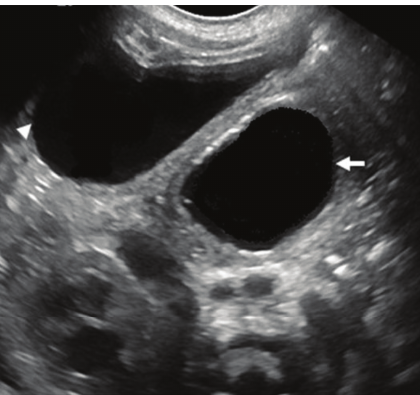
Figure 1: Transverse ultrasound of the pelvis shows a large utricular cyst in the midline (white arrow), posterior to the bladder (white arrowhead).